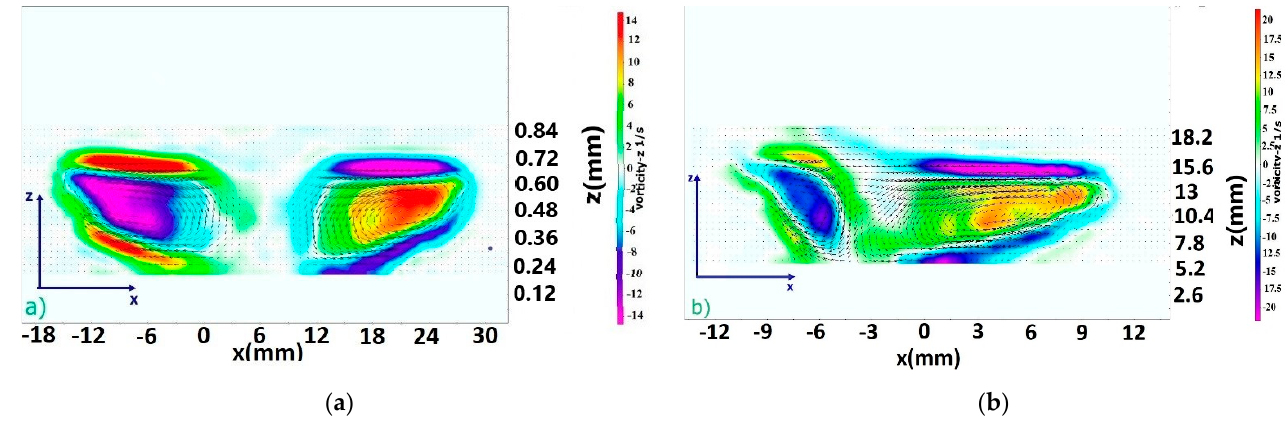
Figure 6. ( a ) Vorticities in the initial phase of the crystal analyzed with particle image velocimetry (PIV). The opposite vortexes and narrow shear islands. ( b ) Vortices after applying the neutral pushing force.